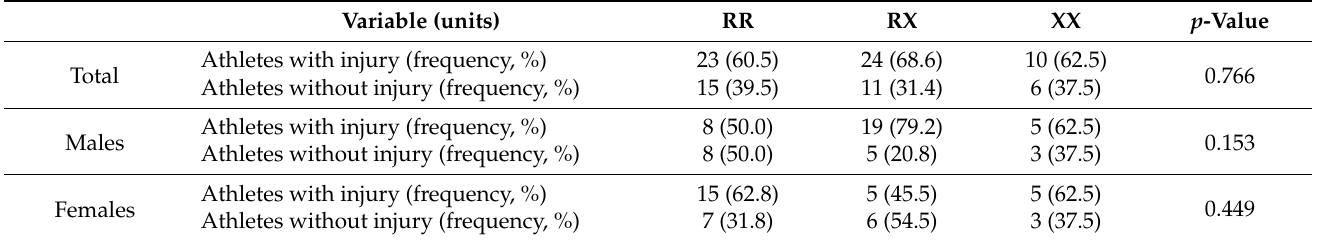
Table 2. Distribution of athletes with/without an injury reported in the preceding season according to their ACTN3 R577X